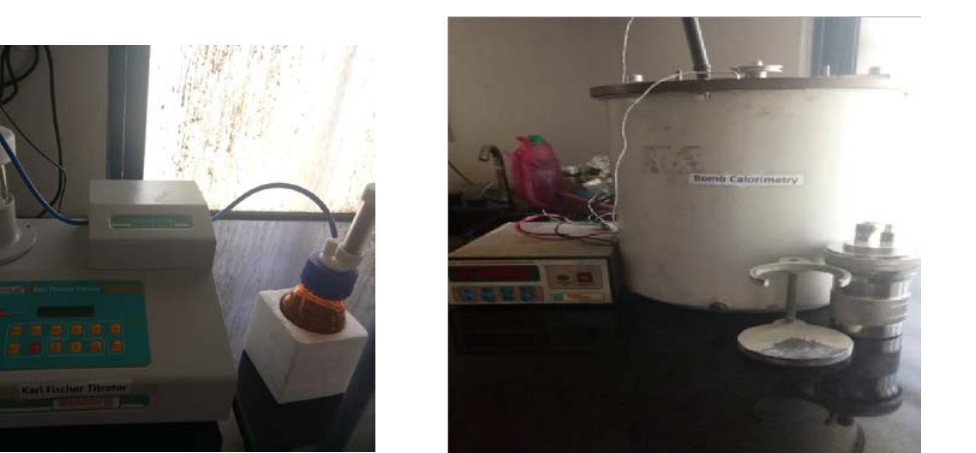
Figure 5: Experimental setup for Water Content test as per ASTM D6 304 standards